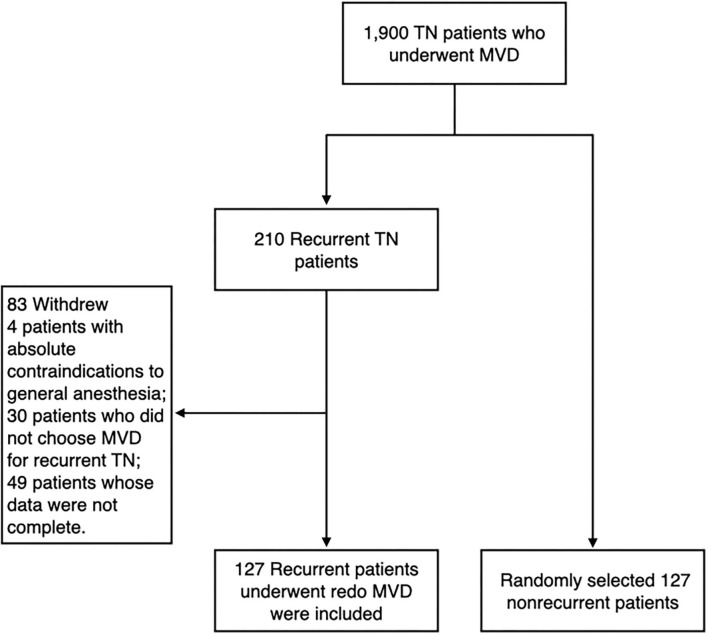
A flowchart of the recruitment.